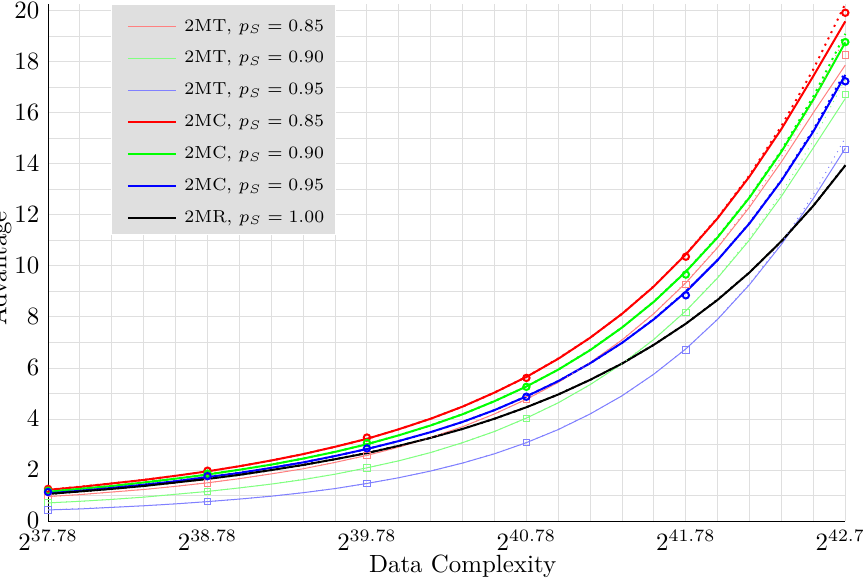
Figure 7: Theoretical and Experimental Advantages for Attacks on